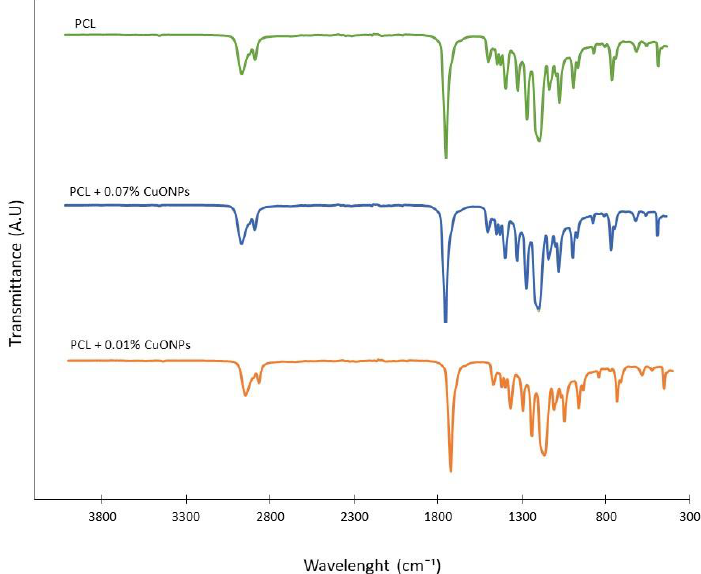
Figure 4. FTIR spectra neat PCL film and active PCL films with different CuONP concentrations.